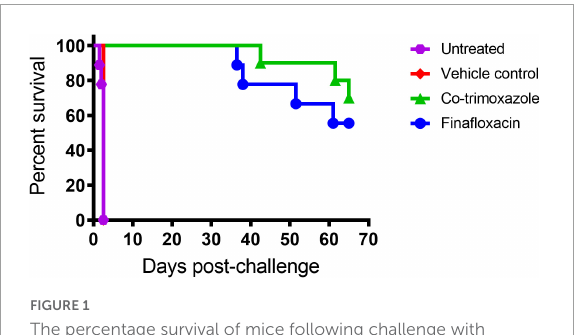
FIGURE1 The percentage survival of mice following challenge with aerosolized B. mallei . Mice were challenged with a mean retained dose of 1.52 × 10 4 CFU of B. mallei by the inhalational route and treated with finafloxacin (37.5 mg/kg) every 8 h or co-trimoxazole (78 mg/kg) every 12 h by the oral route. Control animals received vehicle by the oral route every 8 h. Regimens were initiated at 24 h post-challenge and continued for 14